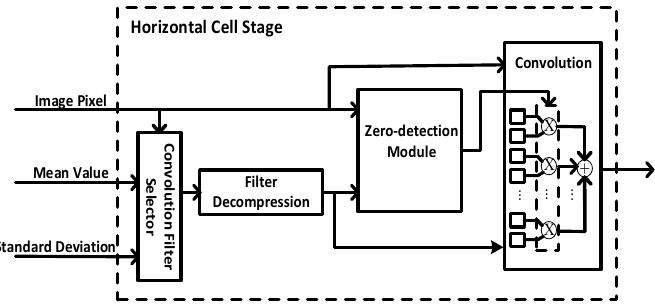
Figure 6. Convolution filter compression with zero skipping convolution.